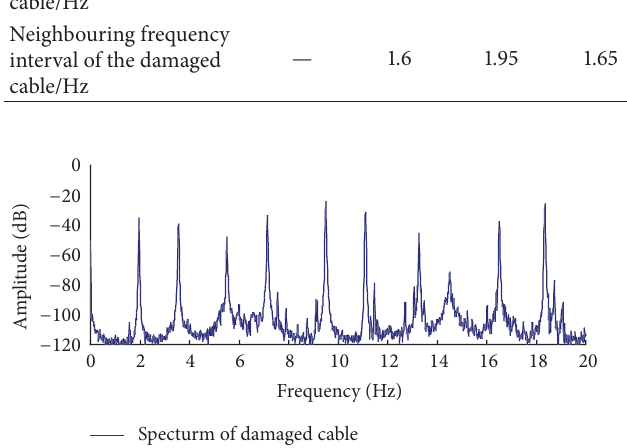
Figure 10: Spectral lines of the damaged cable.